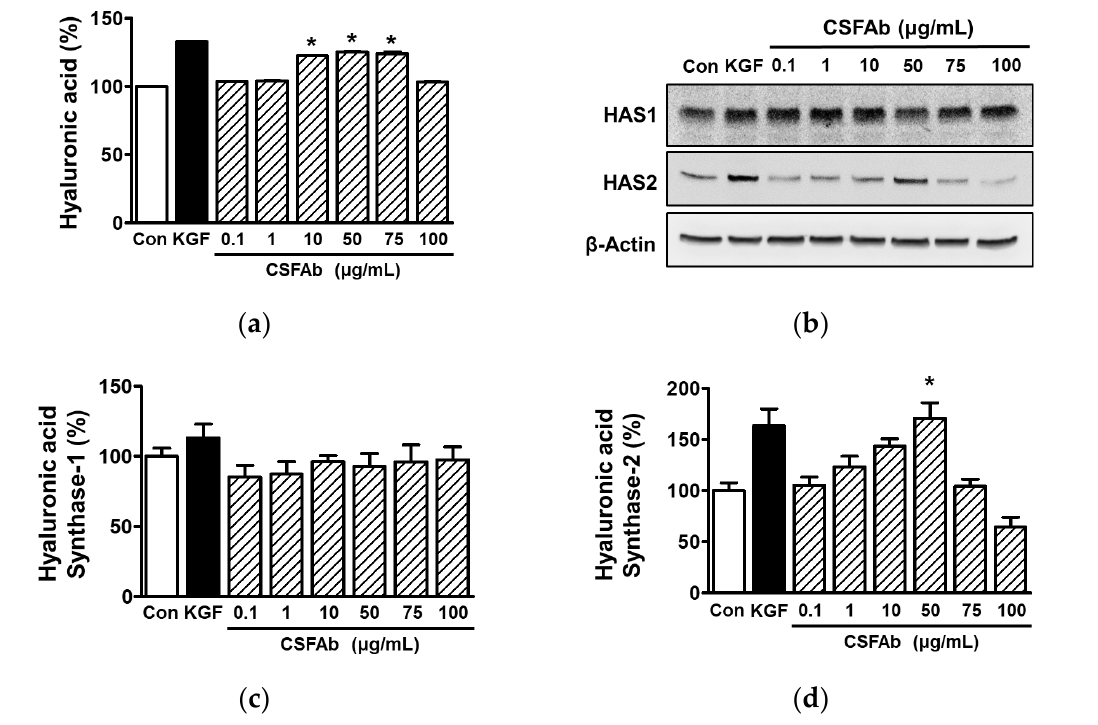
Figure 6. Effects of Caragana sinica flower absolute on hyaluronic acid synthesis in HaCaT cells. ( a ) Hyaluronic acid levels. HaCaT cells were incubated with or without Caragana sinica flower absolute (CSFAb; 0.1–100 μg/mL) for 12 h, and conditioned media were analyzed using an ELISA kit ( n = 3), as described in Section 3. ( b – d ) Expression levels of hyaluronic acid synthases (HASs). HaCaT cells were incubated with or without Caragana sinica flower absolute (CSFAb; 0.1–100 μg/mL) for 12 h, and lysates were immunoblotted with HAS-1, HAS-2, HAS-3, or β -actin antibodies ( n = 3/protein). Recombinant keratinocyte growth factor (KGF: 20 ng/mL): positive control. ( b ) Representative images of results. ( c , d ) Statistical graphs of HAS-1 ( c ) and HAS-2 ( d ) levels in panel ( a ). Results are expressed as mean percentages of untreated controls (Con). * p < 0.05 vs. untreated controls.